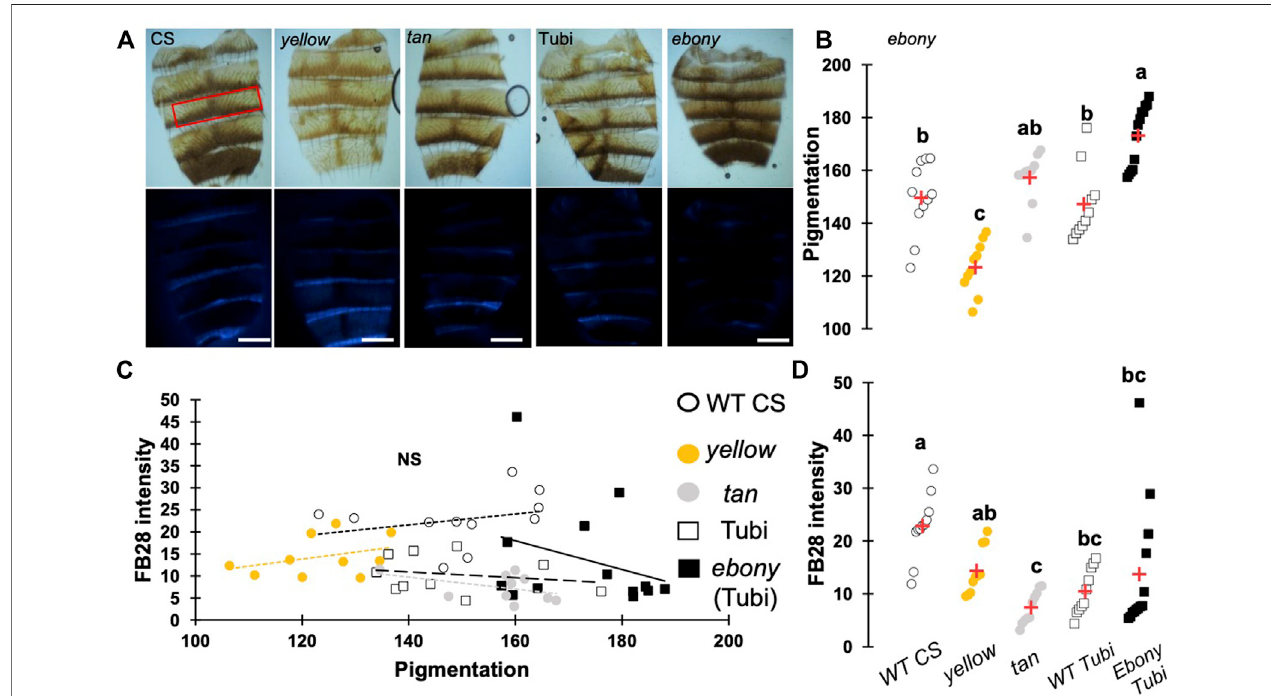
FIGURE 4 | Pigmentation in 48 h-old abdomens poorly affects FB28 intensity compared to sclerotization levels. (A) Images of control fl ies (WT CS), yellow mutant fl iesand tan mutant fl ies. ebony mutantswereobtainedfromwild-typeTübingen2018(Tubi) fl ies.BrightFieldimages(upperpanel)andblue fi lteredimages(lowerpanel) areshown.Scalebars=0.3 mm (B) Quanti fi cationofcuticlepigmentation.Pigmentationwasmeasuredusingthemeangreyvalueinthethirdtergiteasrepresentedbya red rectangle in A. (C) Quanti fi cation of FB28 intensity expressed as a function of pigmentation. No correlation between pigmentation and FB28 were observed (Pearson correlations: − 0.4 < r < 0.3, p -values ≥ 0.2). (D) Quanti fi cation ofFB28 intensityalone. tan mutant fl ies showed asigni fi cantlylowerFB28intensity compared to wild-type fl ies. ebony mutant fl iesshowedasigni fi cant,albeitvariable,higherFB28intensity.Dataarerepresentedasscattergramsshowingalldatapointswiththemean (red crosses). Different marker shapes/colors represent the different genotypes. Different letters indicate statistically signi fi cant differences (one way Kruskall-Wallis test followed by a Conover-Iman procedure, p -value < 0,0001). n > 10 in each group.